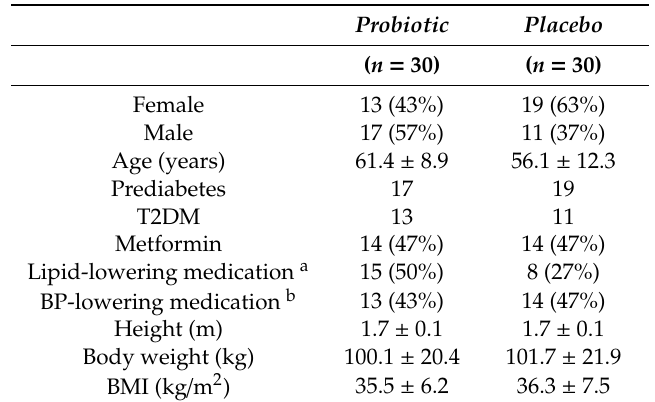
Table 1. Baseline characteristics of participants by treatment